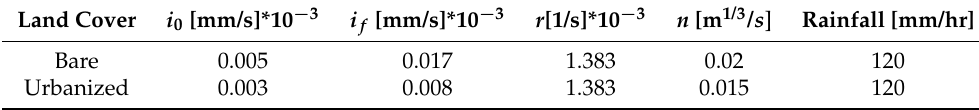
Table 5. Model parameters used for the sensitivity to urbanization